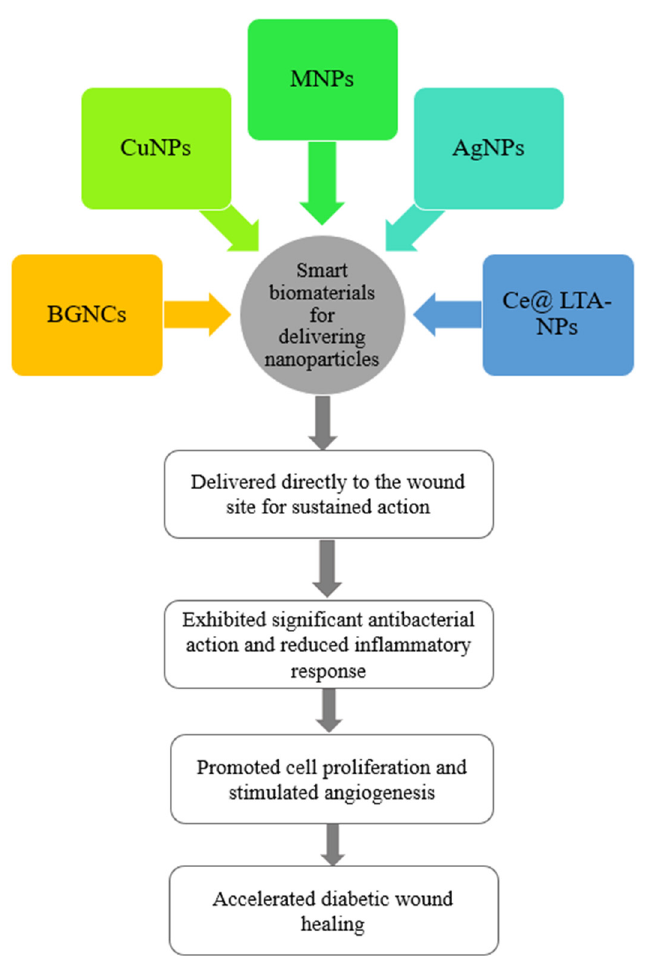
Figure 5. The application of smart biomaterials loaded with nanoparticles in diabetic wound heal-